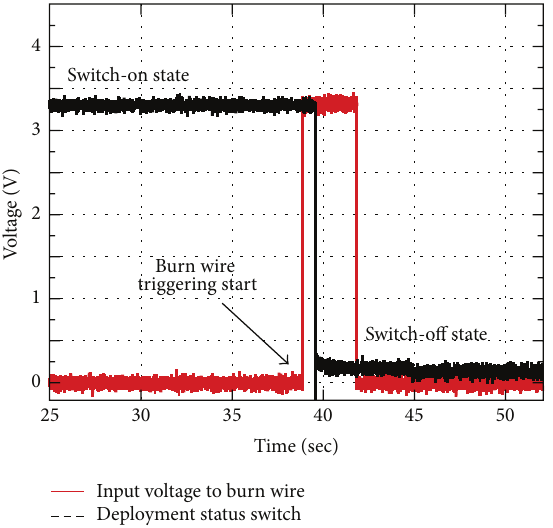
Figure 20: Separation test result of HRM at cold temperature condition.